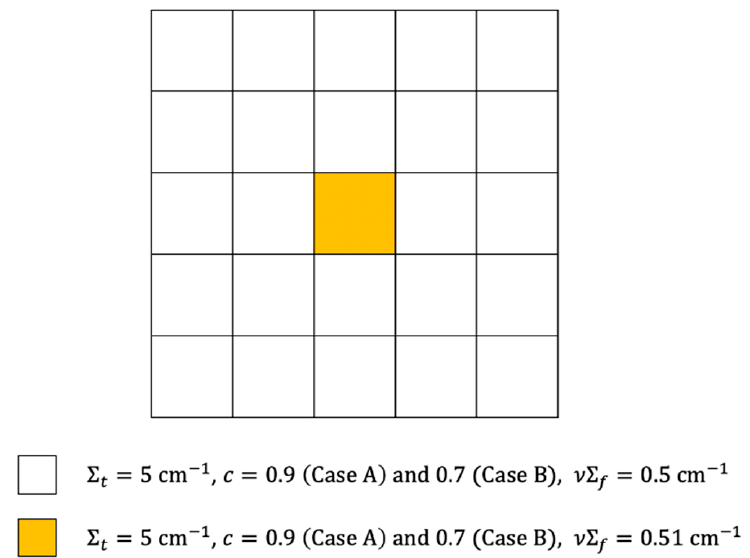
Figure 8. 2D k-eigenvalue test problem.